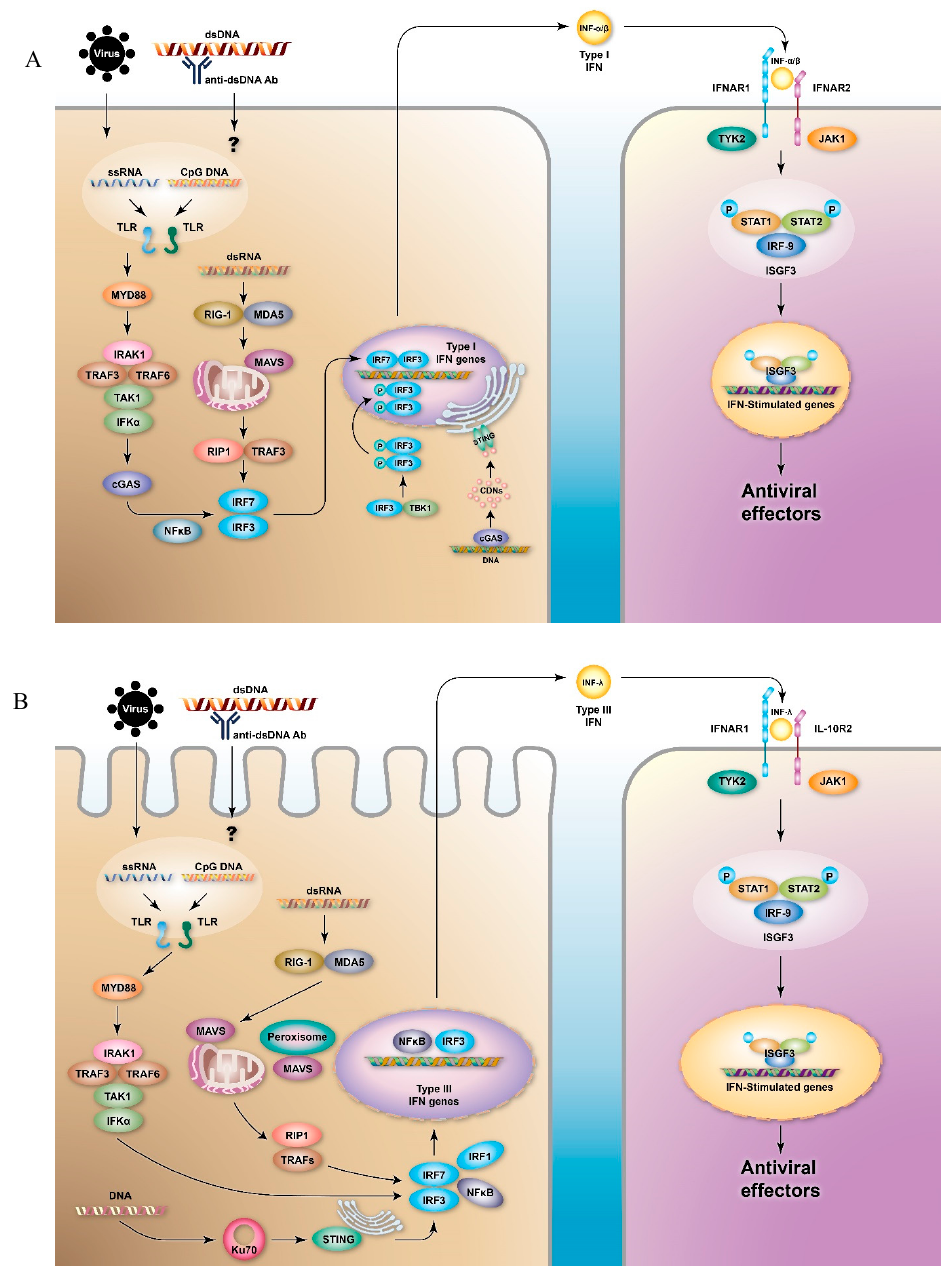
Figure 1. Signaling pathways of type I and type III interferons (IFNs). The production of ( A ) type I and ( B ) type III IFNs can be induced by virus infection or by immune complexes, which are sensed by pattern recognition receptors (PRRs), especially toll-like receptors (TLRs) and retinoic acid-inducible gene 1 (RIG-I)-like receptors (RLRs). Di ff erential signaling molecules lead to the activation of the transcription factors nuclear factor kappa-light-chain-enhancer of activated B cells (NF- κ B) and interferon regulatory factors (IRFs), and eventually to the activation of IFN gene transcripts. The secreted IFNs ligate to the type I or type III IFN receptors (IFN- α / β receptor (IFNAR)1 / IFNAR2 or IFN- λ receptor (IFNLR)1 / interleukin-10 receptor (IL-10R)2, respectively) of the neighboring cells and stimulate the production of IFN-stimulated genes (ISGs) via Janus kinase (JAK)-signal transducer and activator of transcription (STAT) pathways, which results in the production of several antiviral e ff ectors. Cyclic GMP-AMP synthase (cGAS) transforms DNA into cyclic di-nucleotides (CDNs), which can be recognized by stimulator of interferon genes (STING). STING triggers the activation of tank-binding kinase 1 (TBK1) to phosphorylate IRF-3 and induces the transcription of type I IFNs. In the transcription of type III IFNs, the activation of STING is involved in